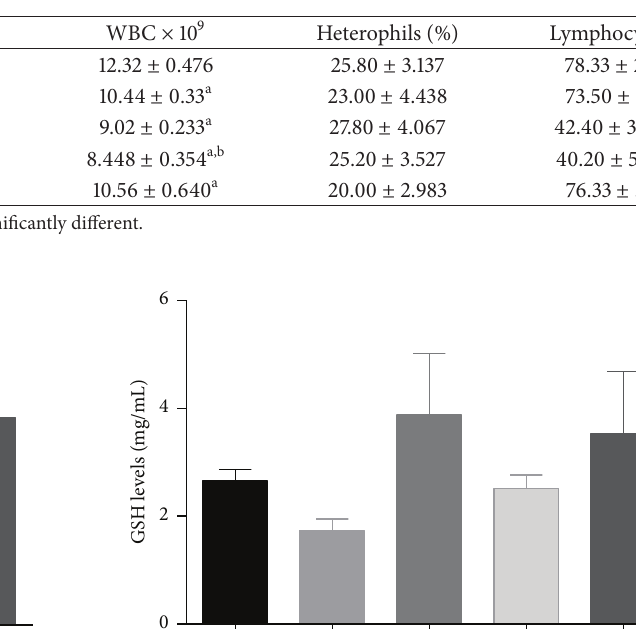
Table 1: Effect of combined extracts of Azadirachta indica and Khaya senegalensis on red blood cell count, haemoglobin concentration, total white blood cell/differential counts of chickens infected with Eimeria oocysts.